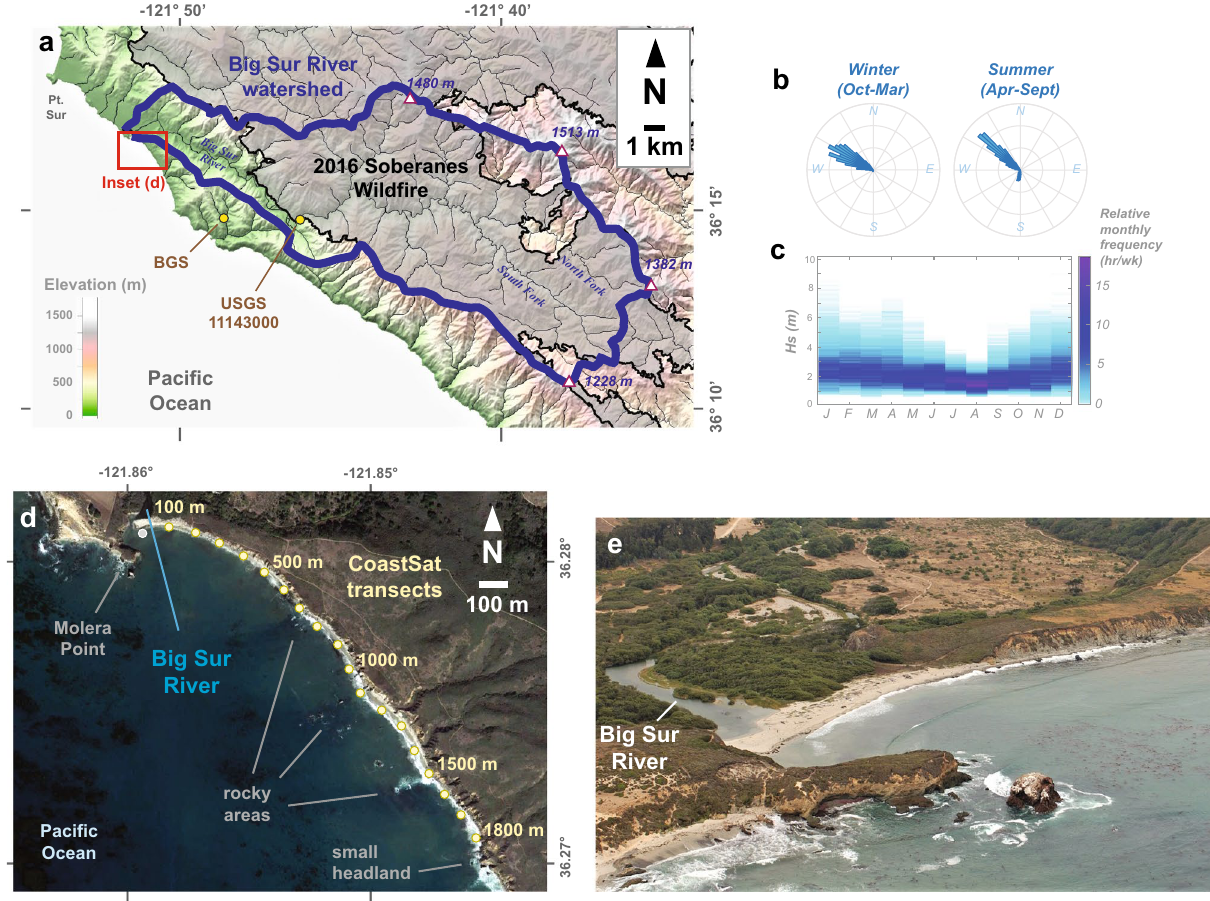
Figure 1. Location and background information of the Big Sur, California study area. ( a ) Watershed map of the Big Sur River watershed, including the boundaries of the 2016 Soberanes wildfire and sampling stations. Map was created in Global Mapper version 21.1.0 (https:// www. bluem arble geo. com/) with data from the USGS 3D Elevation Program, USGS National Watershed Boundary Dataset, USGS National Hydrography Dataset, and the California Department of Forestry and Fire Protection’s Fire and Resource Assessment Program (FRAP). ( b , c ) Offshore wave climatology from the offshore Cape San Martin buoy (Station 46028; 35.770° N 121.903° W). ( d ) Inset map of the Big Sur River mouth and littoral cell study area, including the eighteen CoastSat transects monitored for this study. Map was created from Google Earth Pro version 7.3.4.8248 imagery and data (https:// www. google. com/ earth/ versi ons/) and assembled in Abobe Illustrator version 26.0.2. ( e ) An oblique aerial photo of the Big Sur River mouth and approximately 500 m of the study area beach from Sept. 11th, 2015, when